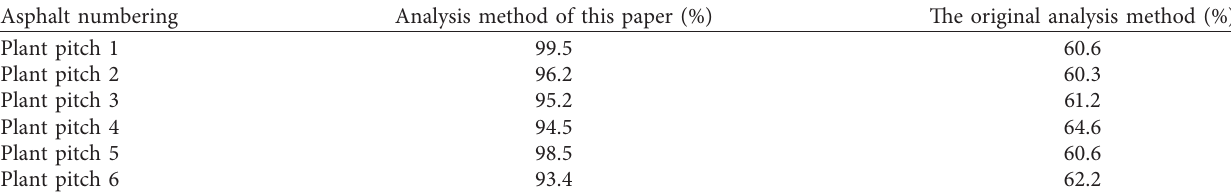
Table 3: Comparison of analysis accuracy of different